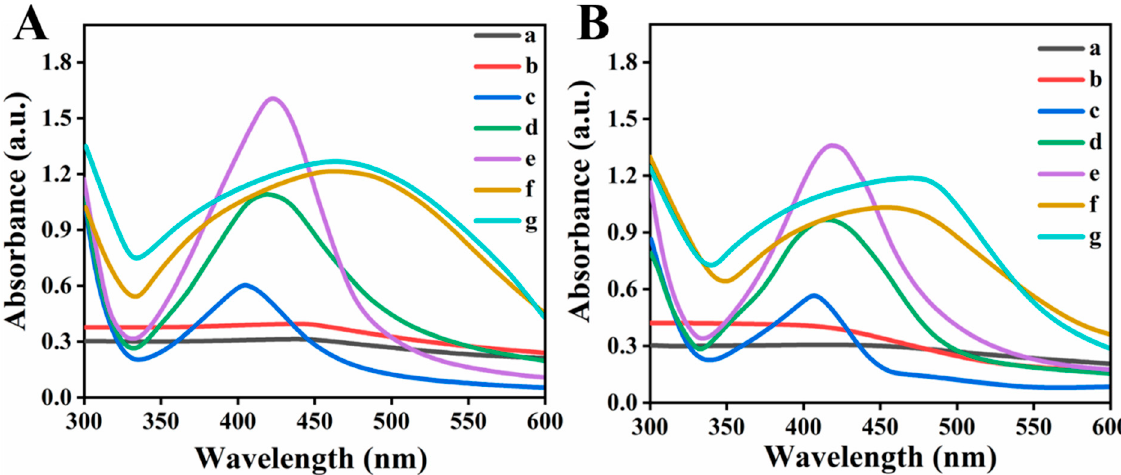
Figure 6. UV spectra of ( A ) R-Ag-NPs and ( B ) L-Ag-NPs stability at different pH (a) 1–2, (b) 3–4, (c) 5–6, (d) 7–8, (e) 9–10, (f) 11–12 and (g) 13–14.